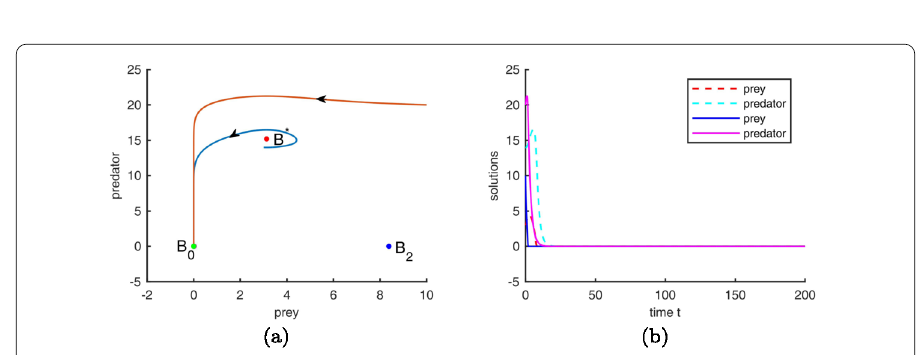
Figure 10 ( a ) The phase diagram of model (1.3) for r = 6, a = 0.1, f = 0; ( b ) solution curves for r = 6, a = 0.1, f = 0. The initial values are (3,14), (10,20)